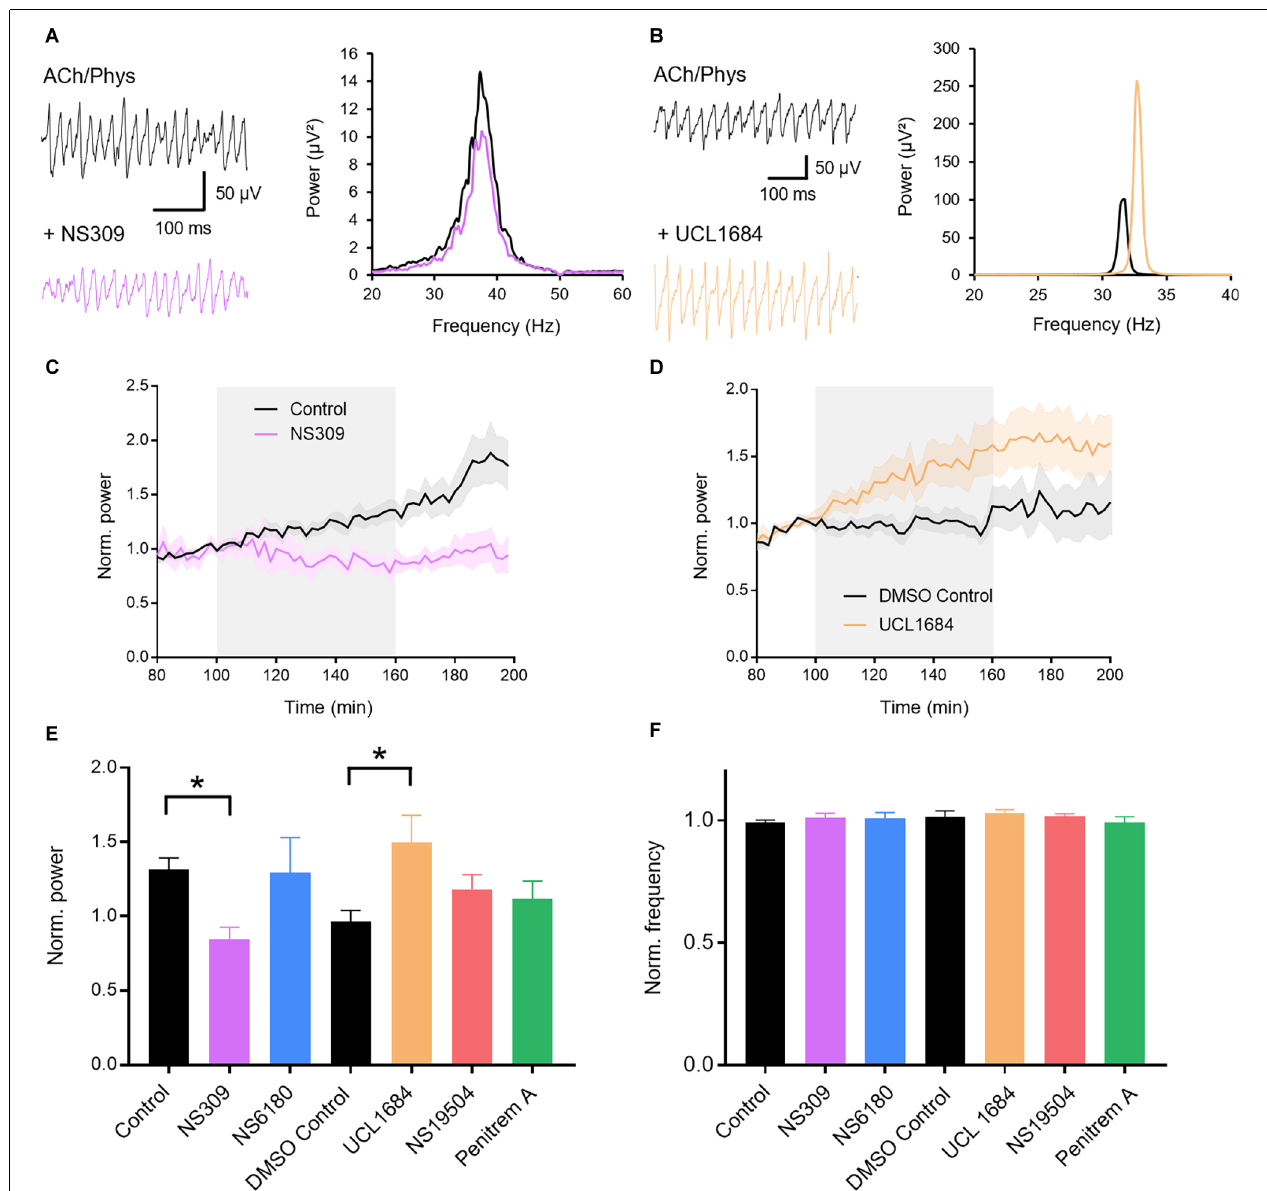
FIGURE 1 | Role of calcium-activated potassium channels (K Ca ) in hippocampal gamma oscillations. (A) Original traces (left) and power spectra (right) of cholinergic gamma oscillations before (black) and after (purple) bath application of the K Ca 2 and K Ca 3.1 activator NS309 (3 µ M). (B) Original traces (left) and power spectra (right) of cholinergic gamma oscillations before (black) and after (orange) bath application of the K Ca 2 antagonist UCL1684 (0.1 µ M). (C) Normalized gamma power before, during and after the application of NS309 (3 µ M, gray area) in comparison to control. (D) Normalized gamma power over time around the application of UCL 1684 (0.1 µ M, gray area) in comparison to control. (E) Effect of K Ca activators and blockers on the normalized peak power of hippocampal gamma oscillations compared to time matched and solvent controls. Control: n = 13 slices, N = 9 animals; NS309 (3 µ M): n = 6, N = 3, p = 0.042; NS6180 (1 µ M): n = 7, N = 3, p = 0.990; DMSO control: n = 8, N = 8; UCL1684 (0.1 µ M): n = 12, N = 6, p = 0.032; NS19504 (10 µ M): n = 14, N = 6, p = 0.565; Penitrem A (0.2 µ M): n = 10, N = 5, p = 0.814. See selectivity in “Results” section. (F) Effect of K Ca activators and blockers on the normalized peak frequency of hippocampal gamma oscillations compared to time matched and solvent controls. NS309 (3 µ M): p = 0.664; NS6180 (1 µ M): p = 0.760; UCL1684 (0.1 µ M): p = 0.858, NS19504 (10 µ M): p = 0.988; Penitrem A (0.2 µ M): p = 0.767. Recording temperature was between 32 and 34 ◦ C. Traces were lowpass filtered at 200 Hz and bandstop filtered at 50 Hz. Bars show mean ± SEM. * p < 0.05. ACh, acetylcholine; Phys, physostigmine.